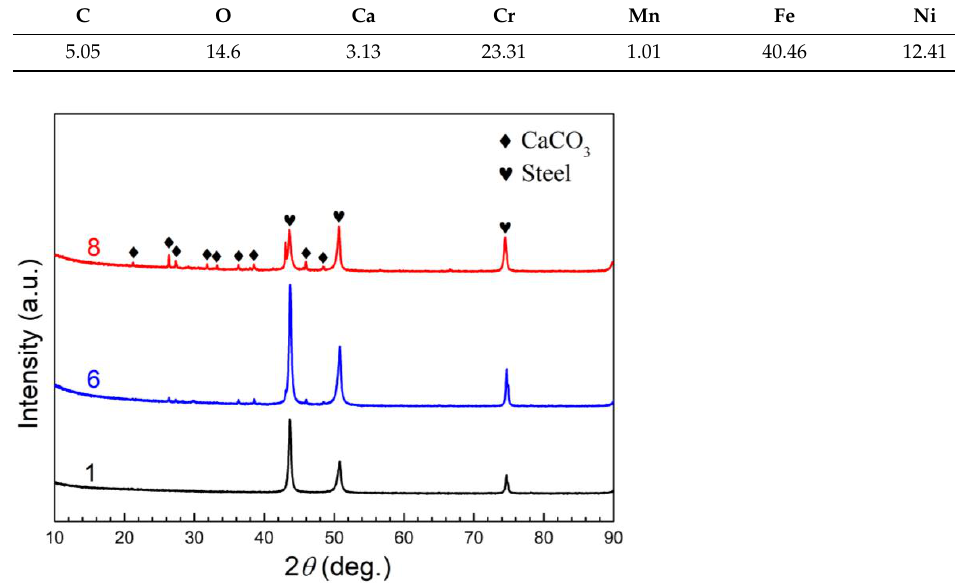
Figure 9. XRD patterns for the specimen surfaces after the polarization measurement in the solutions with the concentration ratio 1, 6 and 8 times.